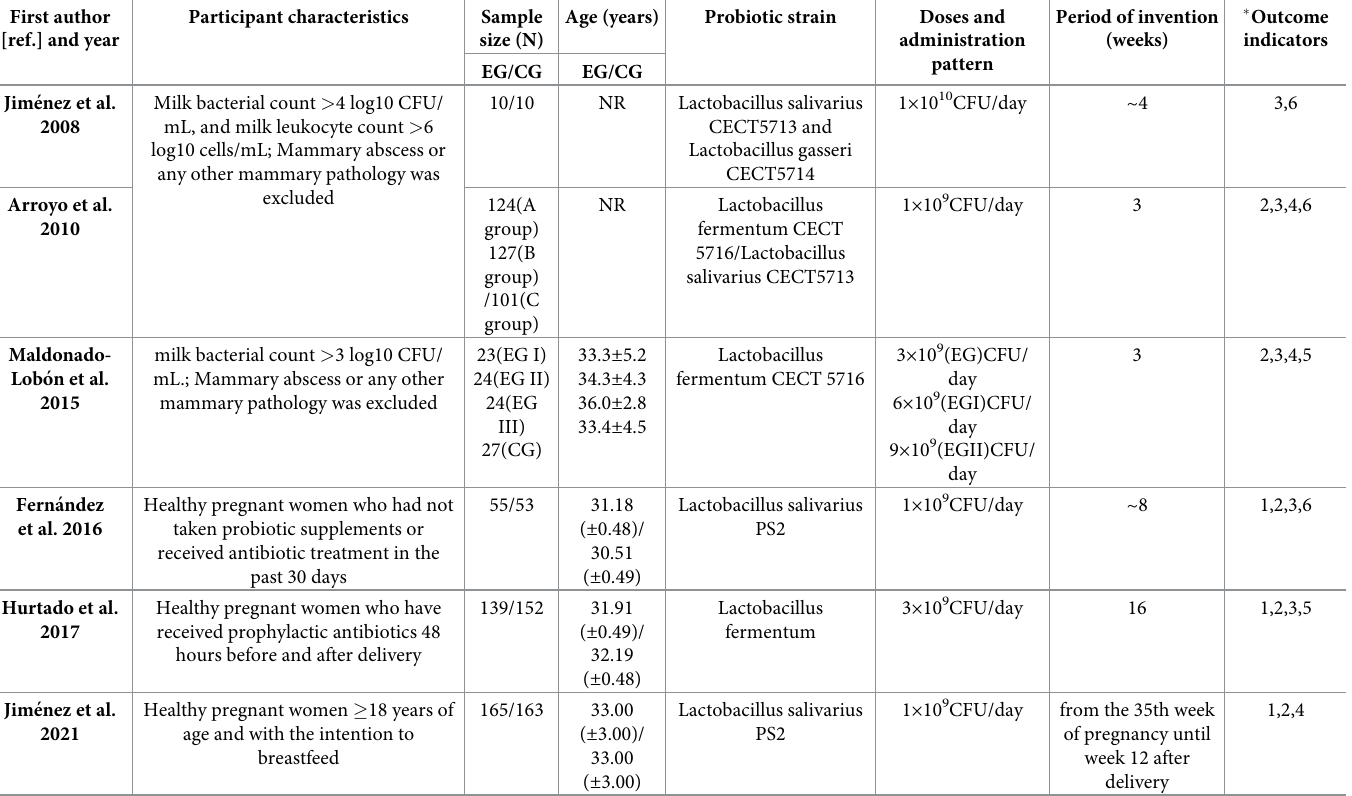
Table 1. Summary of the characteristics of the included studies.